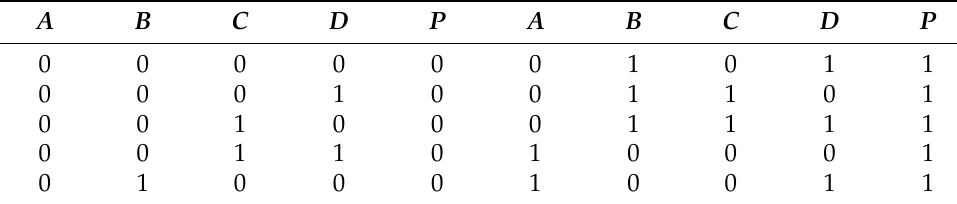
Table 4. The truth table of a rounding logic network in the 8421-BCD